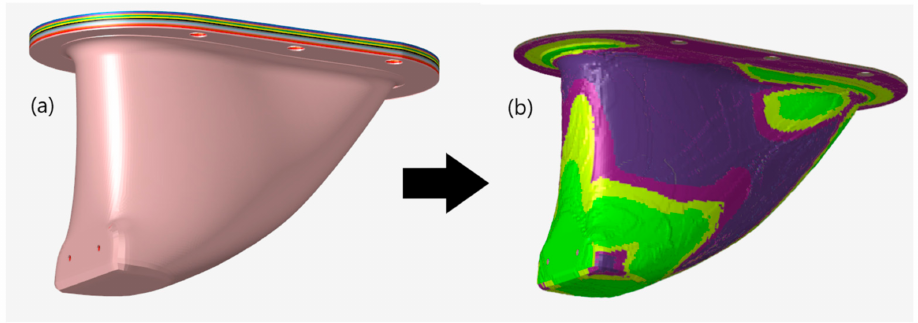
Figure 9. Example of ply geometry details before ( a ) and after ( b ) topology optimization for the integral model without